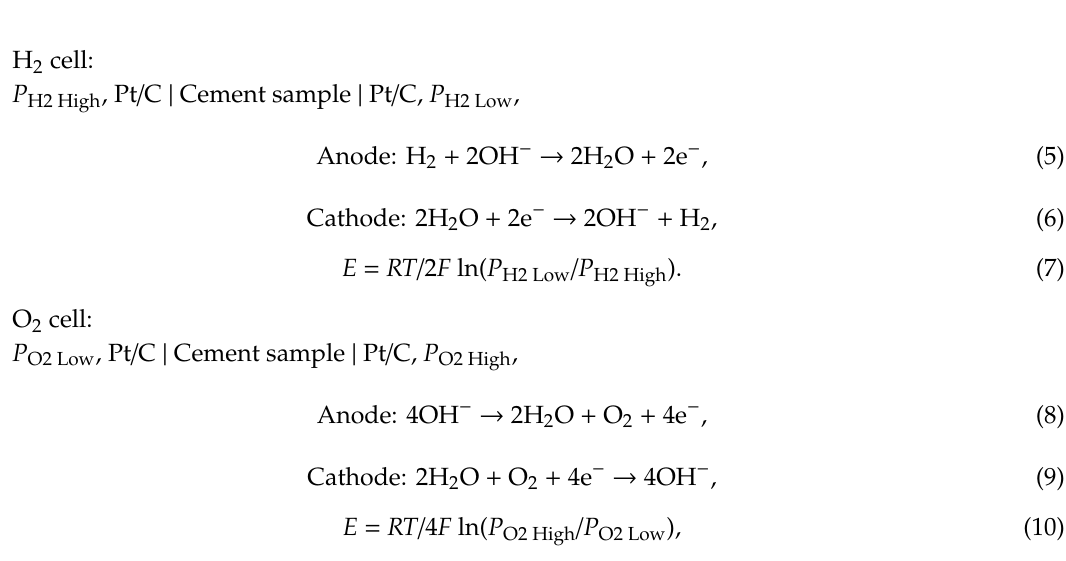
Figure 6. XRD profiles after polarization with a current density of 0.4 mA cm − 2 in humidified air at 70 °C for 60 h, followed by drying in a CO 2 -free container.